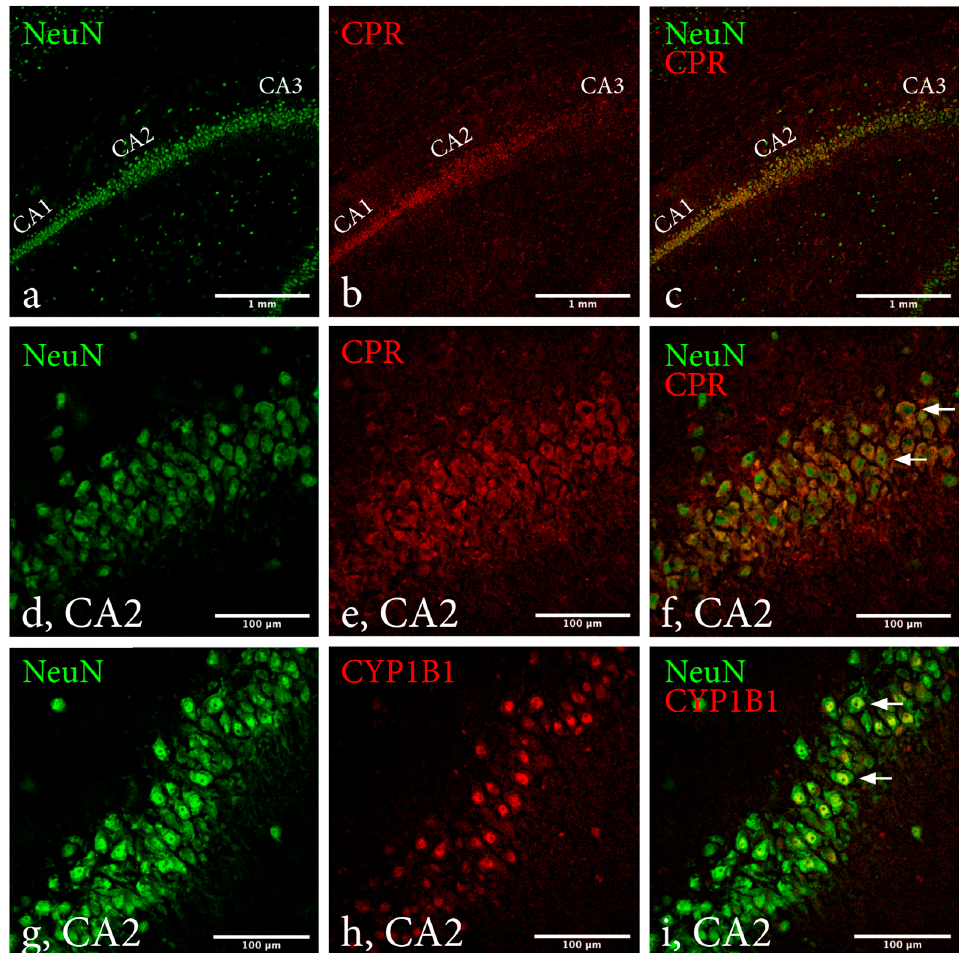
Figure 6. Immunohistochemical evaluation of CYP1B1 and CPR colocalization with NeuN in hip- pocampal subregions. Confocal images depicting an overview of CA1, CA2 and CA3 at 10× magni- fication ( a – c ), subregion CA2 captured at 40× magnification ( d – i ). Green channel ( a , d , g ) depicts NeuN staining, red channel ( b , e , h ) CPR or CYP1B1 and ( c , f , i ) the two channels merged. Distinct colocalization of CPR and NeuN was observed in subregions CA1 and CA2, but not CA3 ( c ). Positive colocalization of CYP1B1 and NeuN was noted in several cells, indicating presence of CYP1B1 protein in CA2 neurons ( i ). Examples of cells judged as positive for CPR or CYP1B1 are marked by arrows. The image was deemed representative of all groups, as no apparent difference was observed between sexes, interventions, or survival times. Abbreviations: CA2: Cornu Ammonis 2, CPR: Cy- tochrome P450 reductase, CYP1B1: Cytochrome P450 1B1.